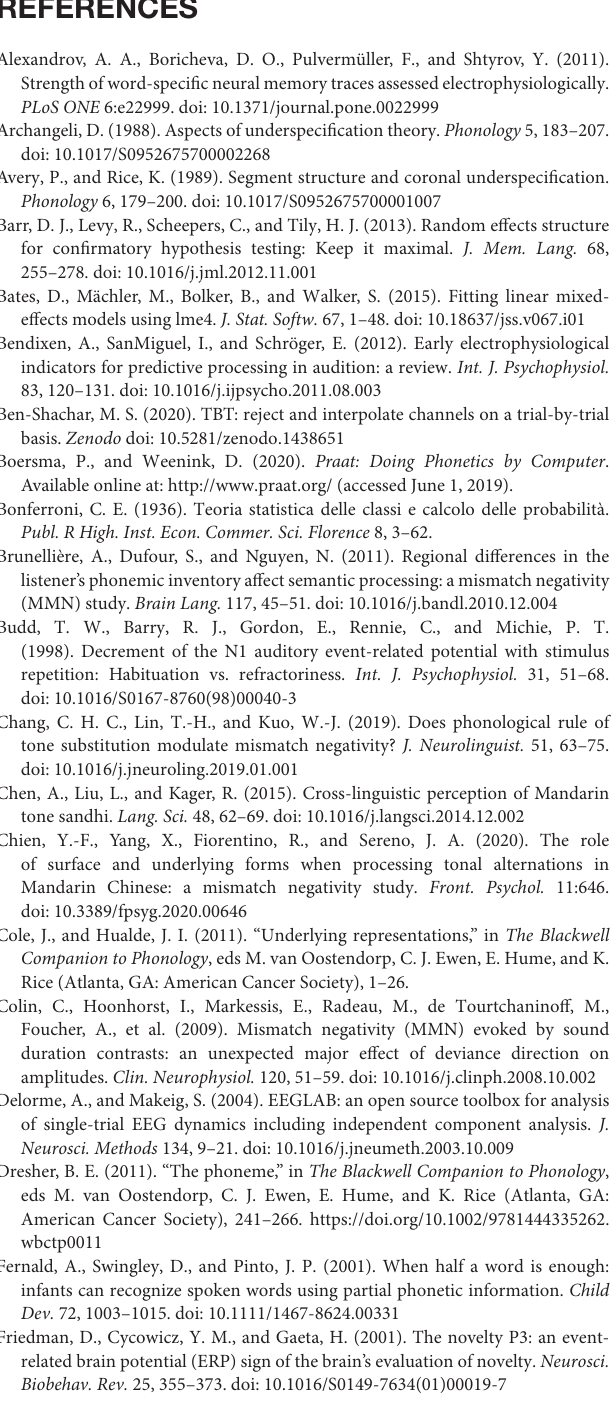
of the first syllable (S1); (3) the voicing portion of the second syllable (S2); (4) the end of S2 characterized by strong creaky voice, not amenable to F0 manipulation. The last row is used for the intensity normalization of the stimuli. Supplementary Table 3 | A summary of the results of the split-half